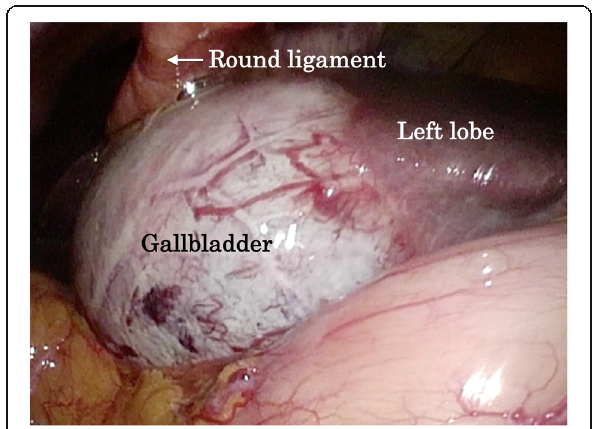
Fig. 4. Intraoperative findings. The gallbladder is attached to the liver at the left side of the round